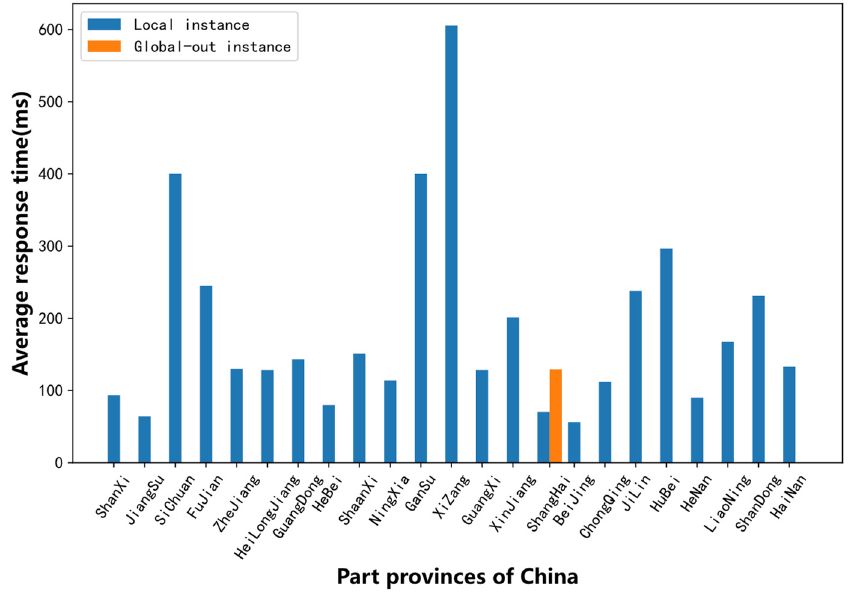
Figure 9. Average response times of two types of nodes of the F root in different provinces.